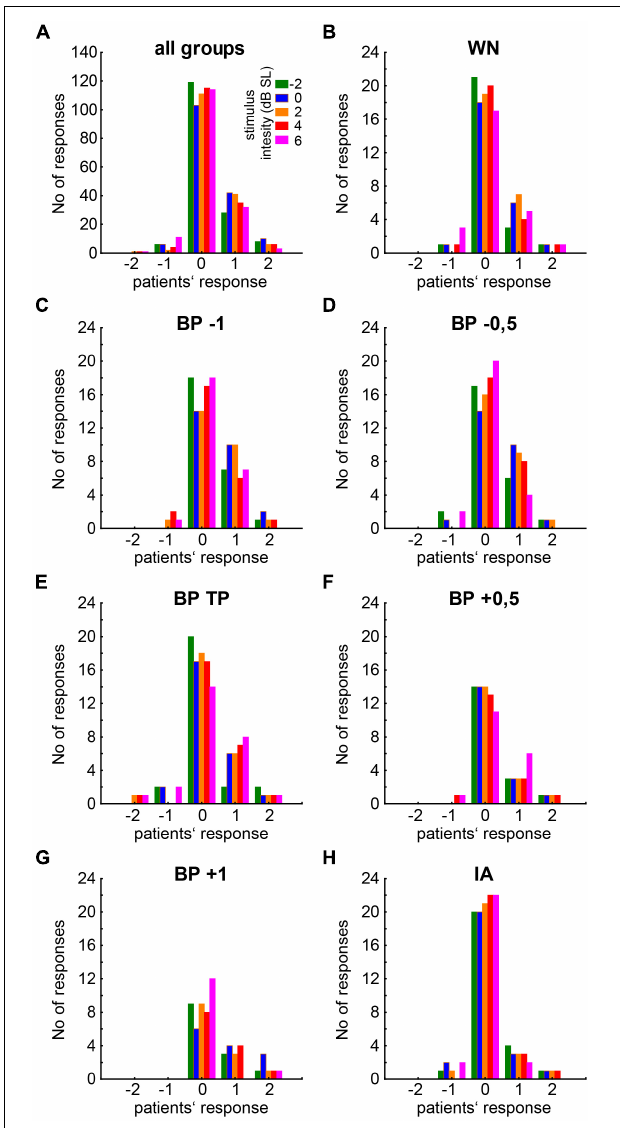
FIGURE 4 | Histogram of patients’ responses to the different stimuli. (A) General overview for all stimuli combined. Colors of the bars indicate the noise intensity of the presented stimulus ranging from –2 to 6 dB SL. (B–H) Responses to the different isolated stimuli types (WN, BP noises relative to TP,